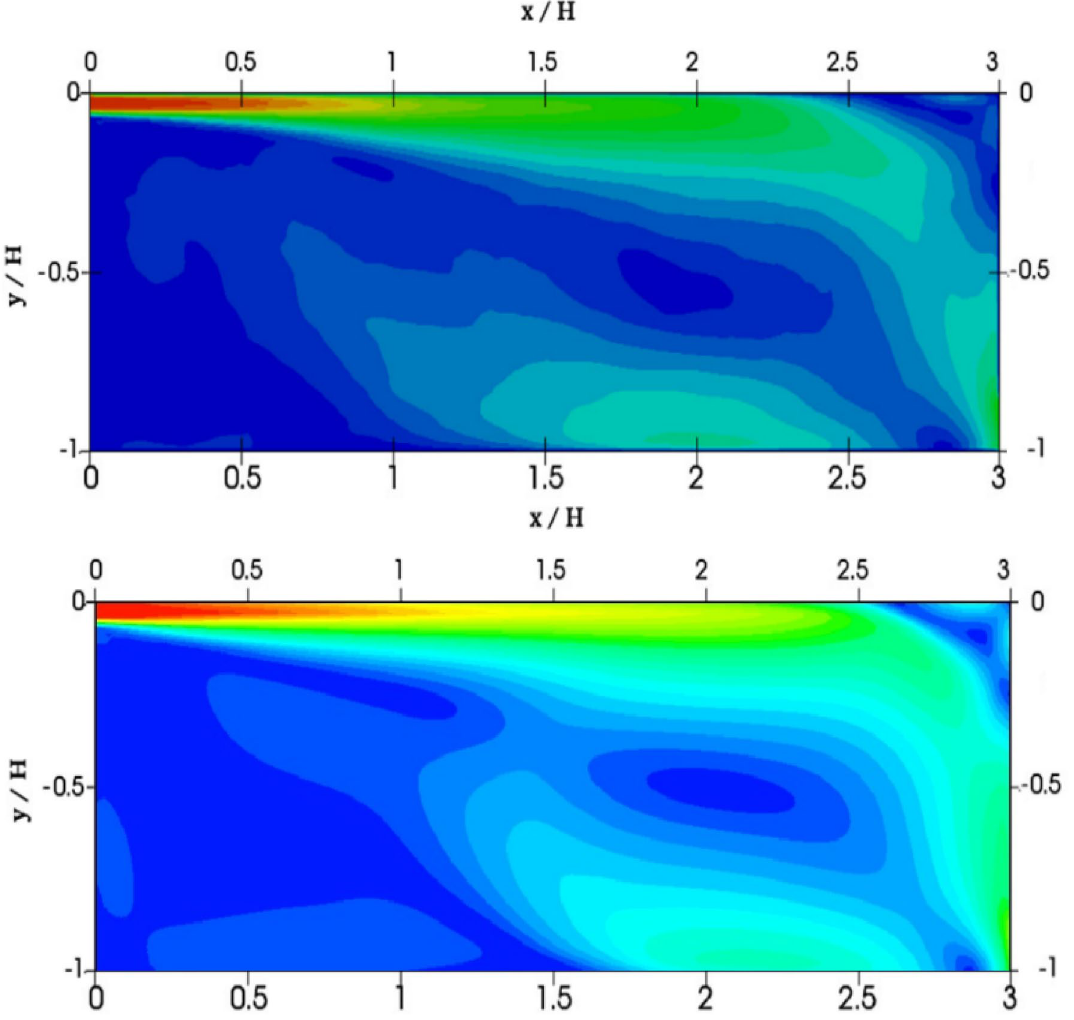
Figure 4. Comparison of the mean velocity contour in the central plane (z = 0): the upper figure is the result of Han et al. 85 , the lower figure is the result obtained in this